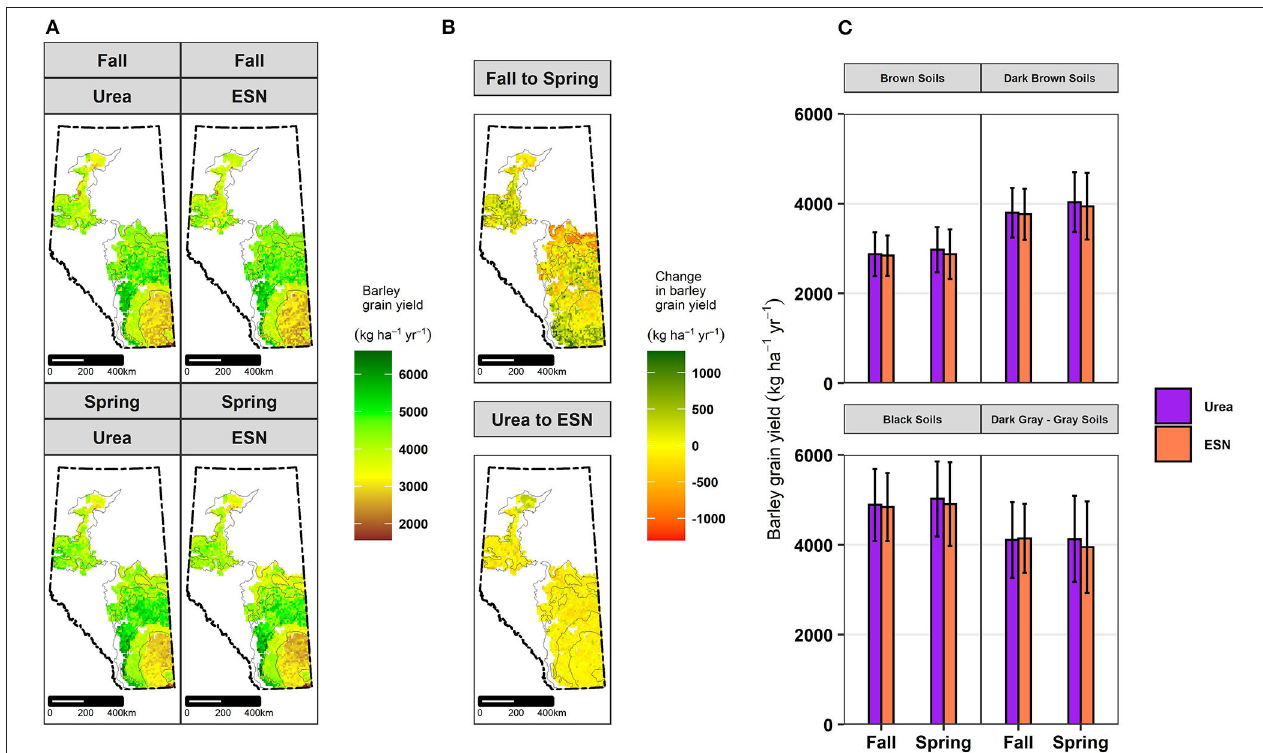
FIGURE 7 | (A) Spatial distribution of modeled dryland or rainfed barley grain yields averaged over the simulation period (2011–2015) for each township for each of the fall and spring banded urea and ESN applications across mid-slope landforms of Alberta under simulated barley cultivation. (B) Spatial distribution of differences in modeled dryland barley grain yields for fall vs. spring and urea vs. ESN applications averaged over the simulation period (2011–2015) for each township across mid-slope landforms of Alberta under simulated barley cultivation. A positive change represents an increase in yield for a change from fall to spring or from urea to ESN and vice versa. The white areas on the map were not modeled based on the selection criteria as described in section Methodology and Model Inputs. The thick dashed lines on the maps represent Alberta’s provincial boundary, and the thin black lines within the maps demarcate soil group areas. (C) Soil group-wise averages of modeled dryland barley grain yields for fall vs. spring banding and urea vs. ESN applications averaged over the simulation period (2011–2015) for all the townships in each soil group area across mid-slope landforms of Alberta under simulated barley cultivation. Error bars represent standard deviations illustrating spatiotemporal variations in modeled grain yields within each soil group